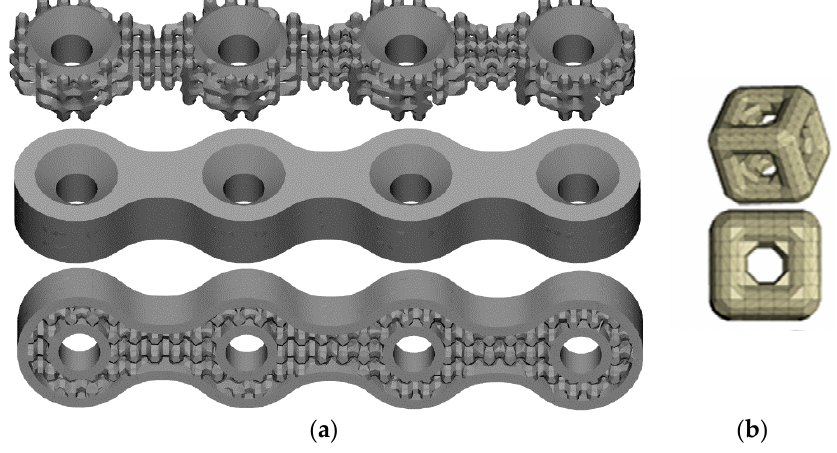
Figure 1. ( a ) Overall geometry of the fabricated bone fixation plates and ( b ) unit pore cell used for creating the porous bone fixation plates.